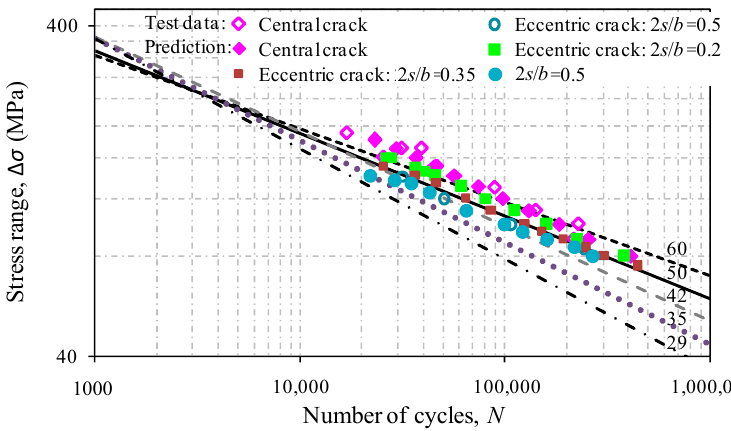
Figure 10. Comparison of fatigue live results between centrally and off-centrally cracked plates.